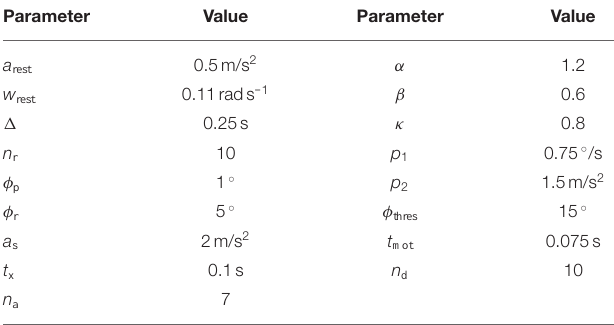
TABLE 1 | Parameter values used in the gait-phase-detection algorithm.